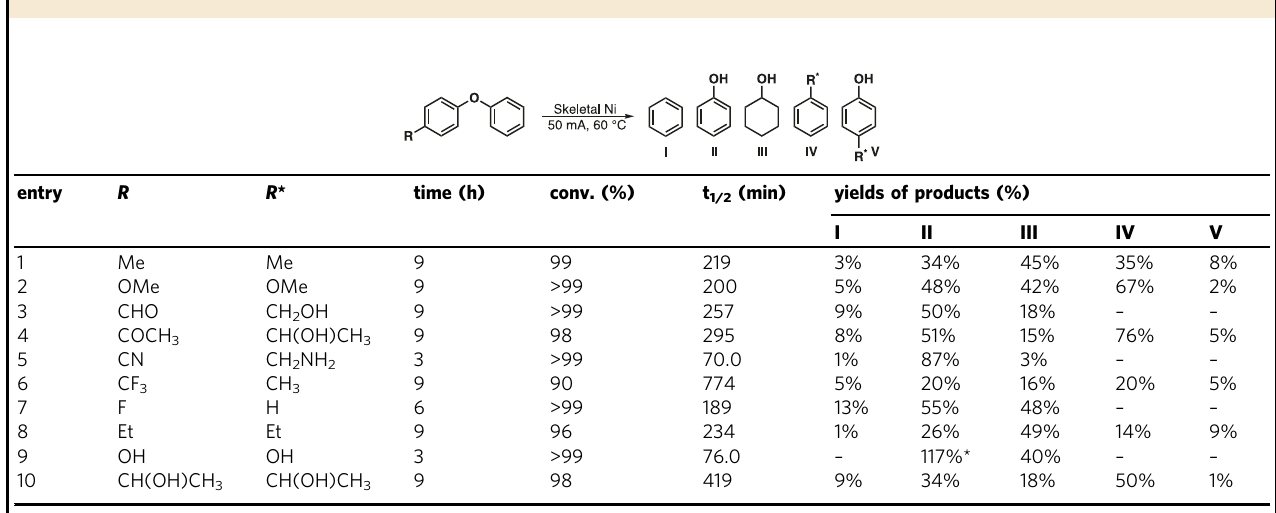
Table 2 Substrate Scope of Diphenyl Ether ECH